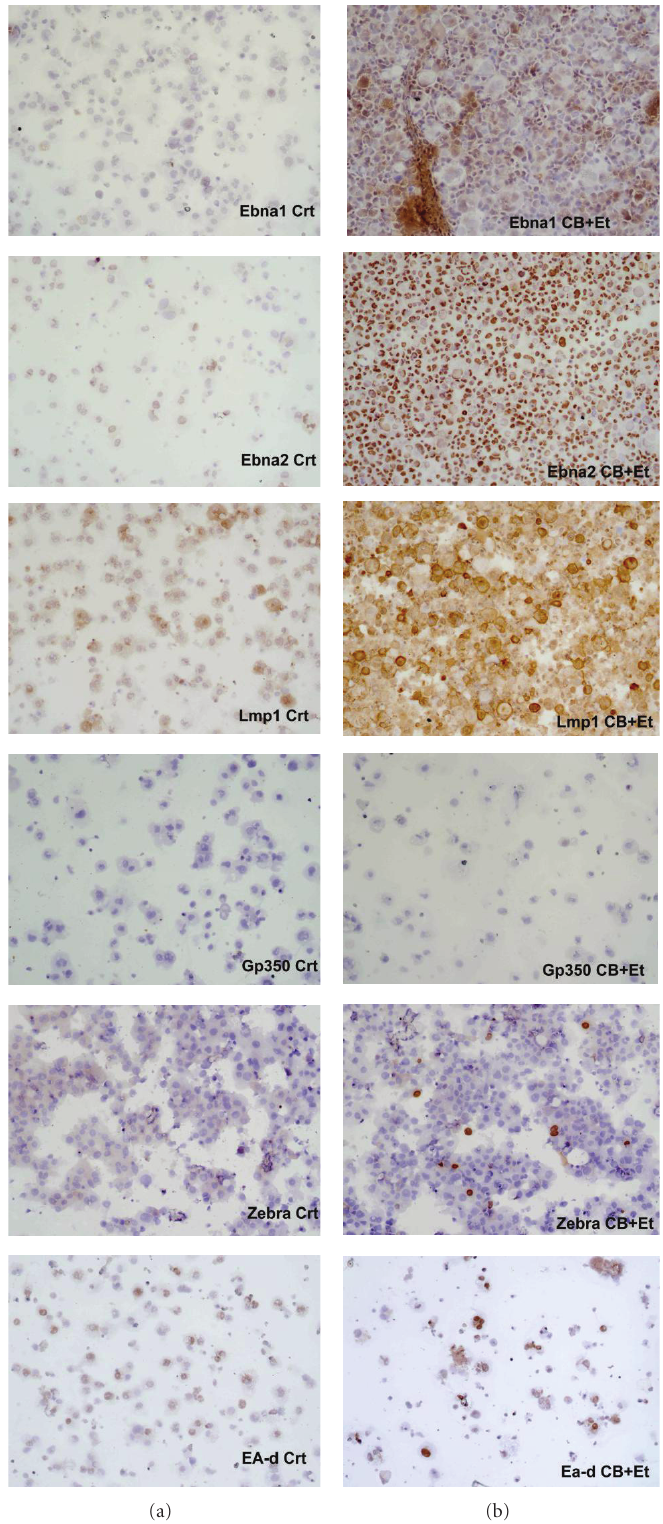
Figure 3: Immunocytochemistry of untreated (a) and E. tirucalli -treated cells (b). The expression of EBV-coded products was